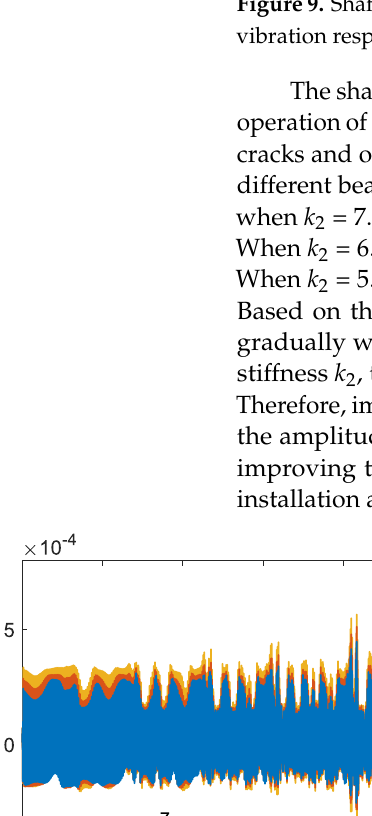
Figure 9. Shafting vibration response in the X and Y directions of the unit with different e 2 ; ( a ) shaft- ing vibration response in X direction; ( b ) shafting vibration response in Y direction.